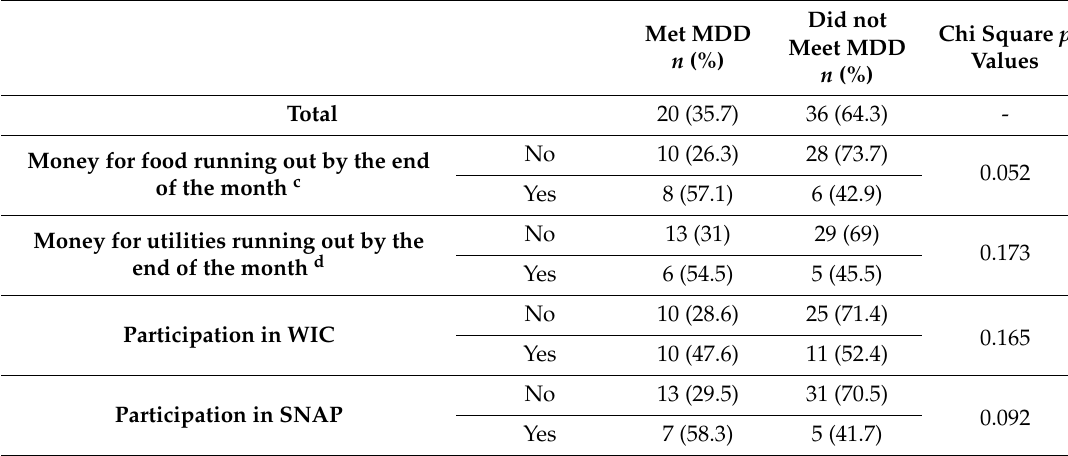
Table 6. Proportion of infants aged 6–12 months enrolled in the cross-sectional study meeting the Minimum Dietary Diversity (MDD) score a by the various indicators of food security examined in this study ( n = 70) b